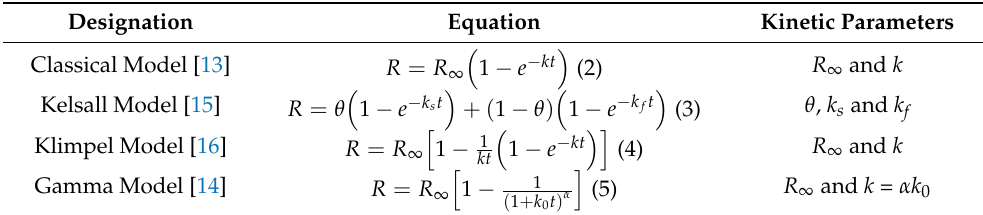
Table 1. Description of the flotation kinetics models tested in this